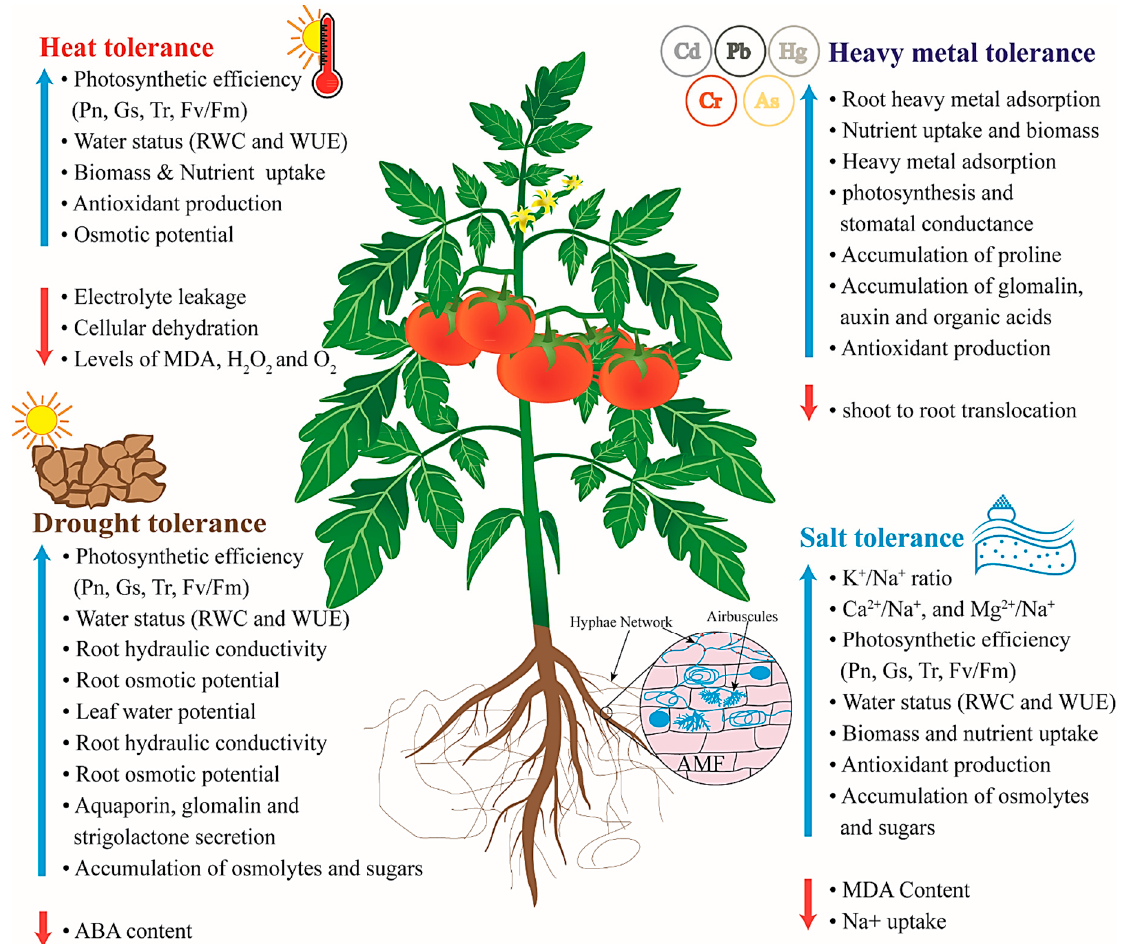
Figure 1. Effects of arbuscular mycorrhizal inoculation on abiotic stress alleviation in tomato.